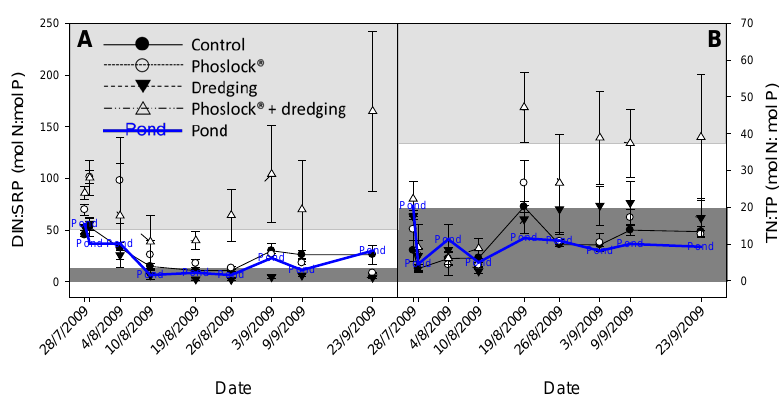
Figure A2. The course of the molar DIN:SRP (Panel A ) and TN:TP ratio (Panel B ) in control enclosures, Phoslock ® -treated enclosures, dredged enclosures, combination Phoslock ® -treated and dredged enclosures, and the pond over the 58-d experimental period in 2009. Error bars indicate one standard deviation ( n = 3). The dark gray background plane indicates the area of N limitation (DIN:SRP < 13; TN:TP < 20), the light gray area indicates P limitation (DIN:SRP > 50; TN:TP > 38), while the white areas indicate no limitation (cf.